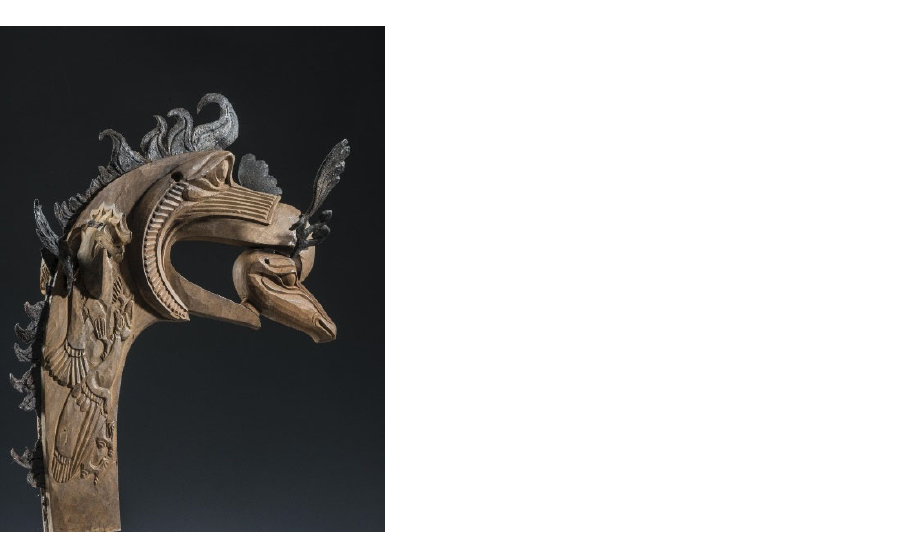
Figure 13. Finial in the form of a griffin holding a stag’s head in its beak (SHM inv. no. 1684-170); cedar wood and leather; Kurgan 2, Pazyryk, Altai mountains, Russia; 5th century BC. [Image is used from www.hermitagemuseum.org (accessed 9 November 2022), courtesy of the State Hermitage Museum, St. Petersburg, Russia].